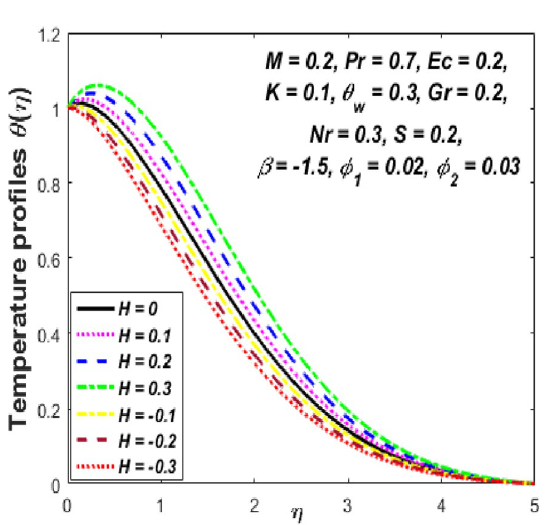
Figure 8. Influence of H on temperature θ(η)